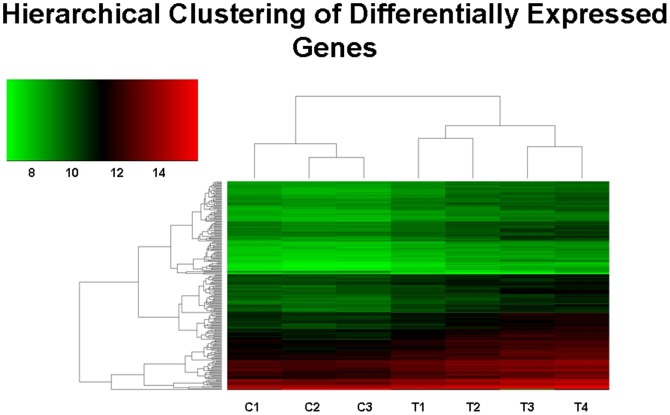
Hierarchical clustering analysis of genes differentially expressed under elevated 5-HT conditions in MK cells.The expression pattern of 233 genes whose expression was changed significantly (FC>2, p<0.001) in saline (n = 3, denoted as C1–C3) and 5-HT-treated (n = 4, denoted as T1–T4) samples are shown. The data were clustered using the standard hierarchical method with average linkage and using the Pearson correlation to determine the distance function. The normalized expression index for each gene (rows) in each sample (columns) is indicated by a color code (see Expression index bar at top left of figure). The genes shown represent the genes that were up-regulated (red) and down-regulated (green) in the sample sets. Samples with similar patterns of expression of the genes studied will cluster together, as indicated by the dendogram.